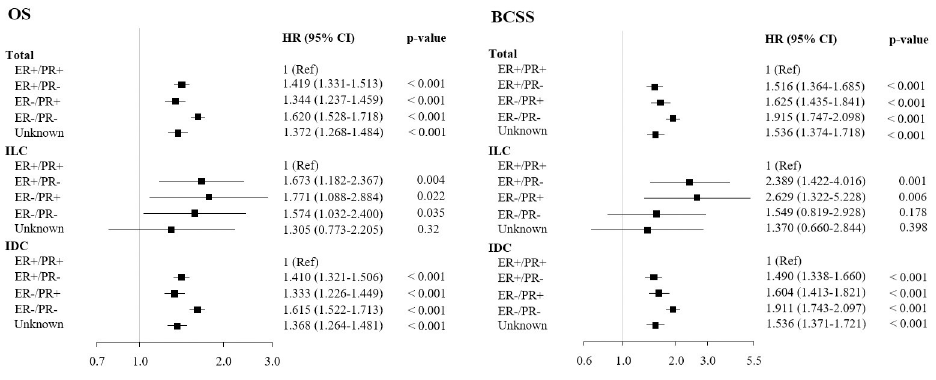
Fig 4. Cox regression analysis of survivals by hormone receptor